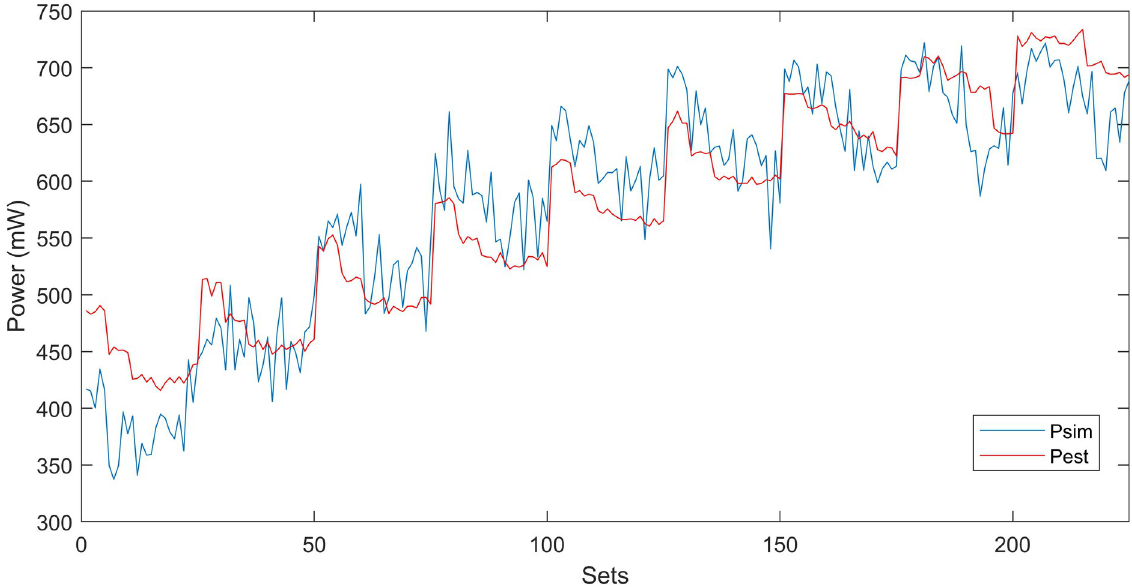
Fig 7. Correlation between simulated and estimated powers for test-system